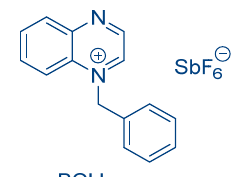
Figure 35. Chemical structure of BQH.